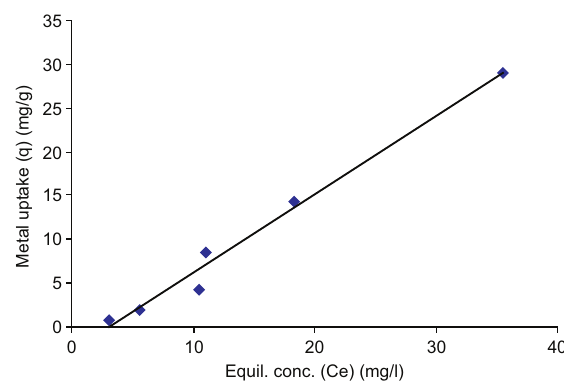
Figure 7 Adsorption isotherm for